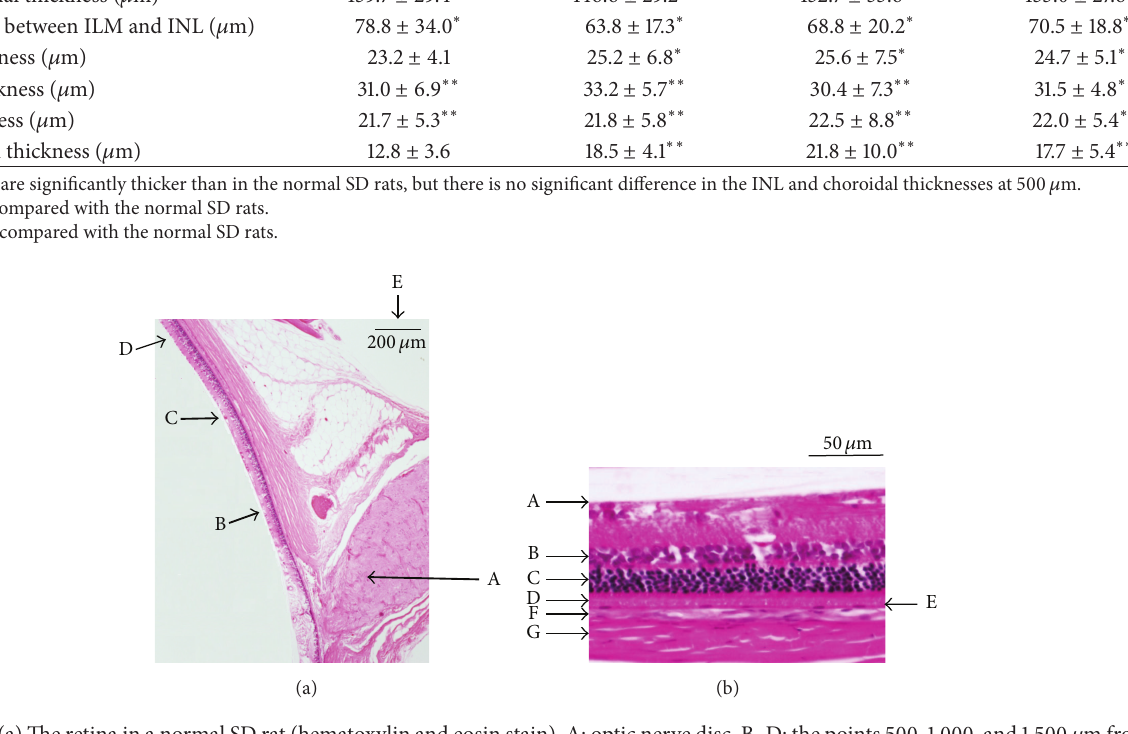
Figure 6: (a) The retina in a normal SD rat (hematoxylin and eosin stain). A: optic nerve disc. B–D: the points 500, 1,000, and 1,500 𝜇 m from the optic nerve disc, respectively. E: index bar = 200 𝜇 m. (b) The retina and choroid 400 to 600 𝜇 m from the optic nerve disc. A: ILM. B: INL. C: ONL. D: PL. E: RPE. F: choroid. G: sclera.